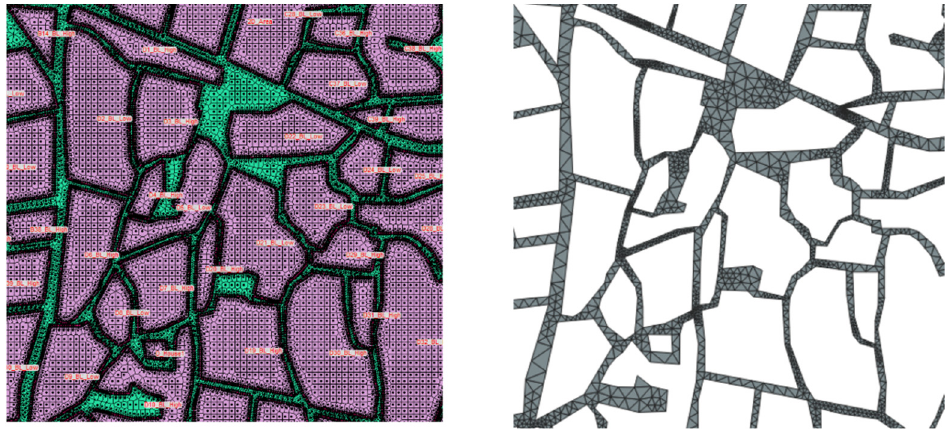
Figure 9. Mesh generation with HEC-RAS (left) and MIKE FLOOD (right) software.